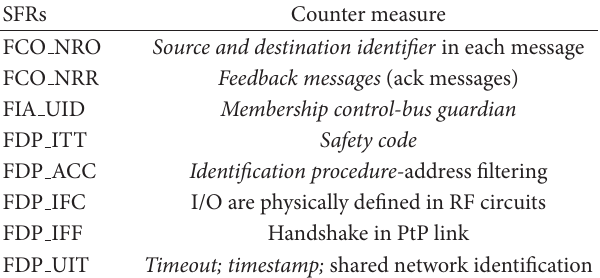
Table 1: Defense methods versus CC requirements.